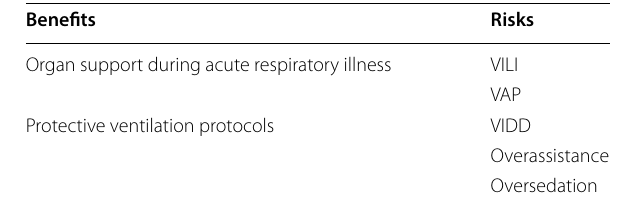
Table 1 Benefits and risks deriving from invasive mechanical